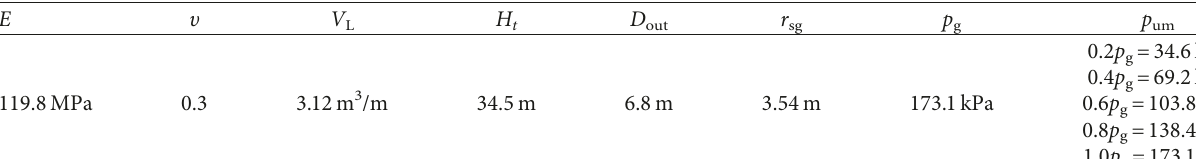
Table 1: Parameters used in the analysis.